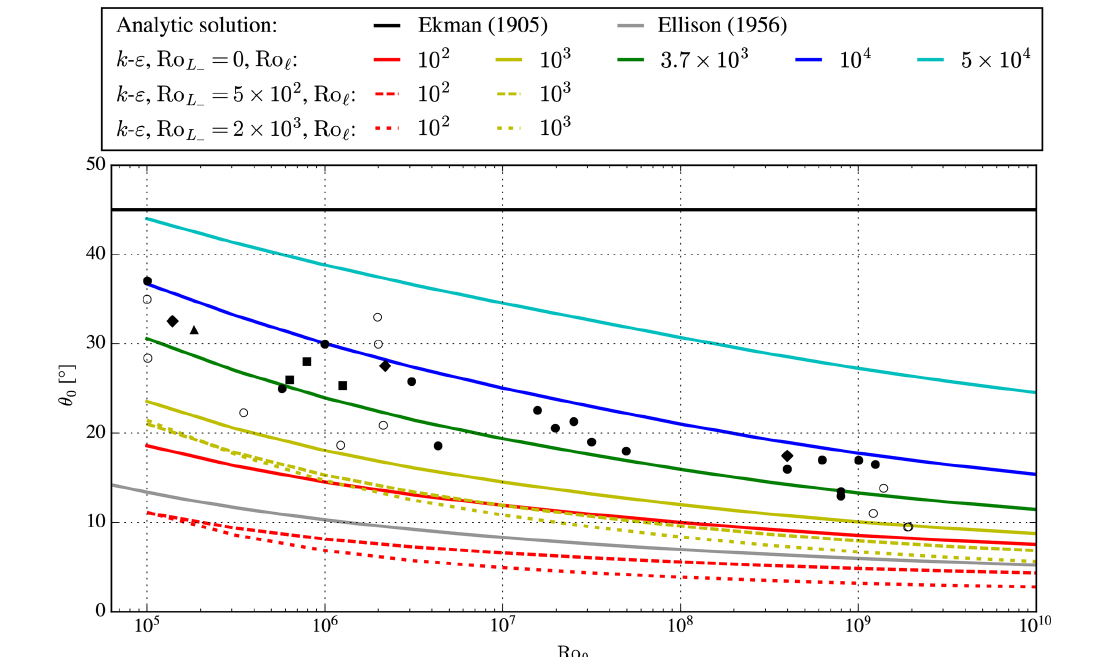
Figure 7. Reproduced from Hess and Garratt (2002). Cross-isobar angle simulated by the limited-length-scale k – ε model extended to unstable surface layer stratification, taken at a normalized height of ( z + z 0 ) | f c | /G = 5 × 10 − 5 for different Ro 0 , Ro (cid:96) , and Ro L markers represent measurements from Hess and Garratt (2002). Ro (cid:96) = 3 . 7 represents (cid:96) max from Blackadar (1962). Analytic results of Ekman (1905) and Ellison (1956) are summarized in Appendix